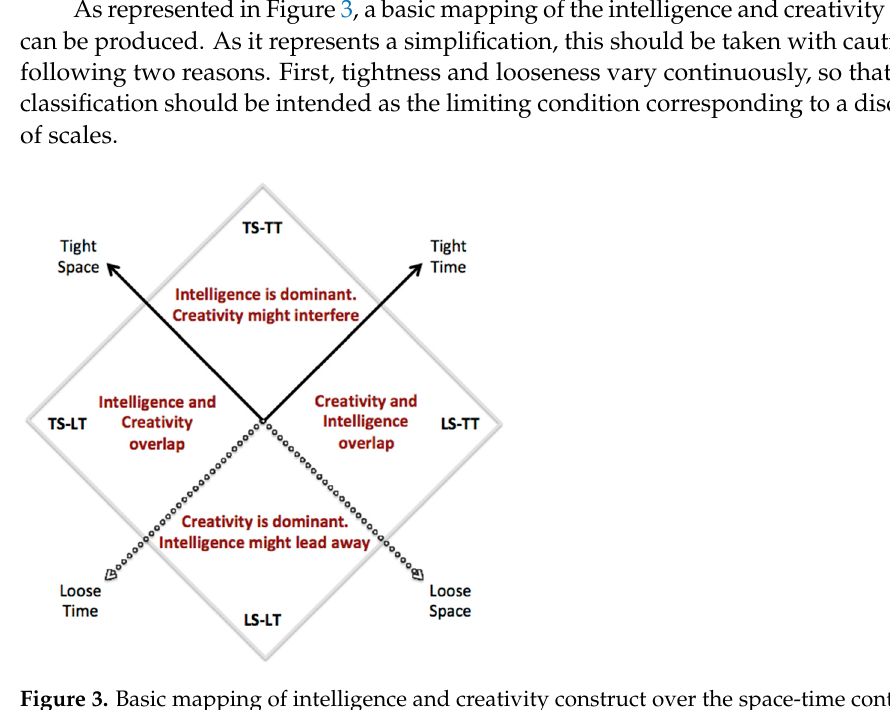
Figure 3. Basic mapping of intelligence and creativity construct over the space-time continuum.